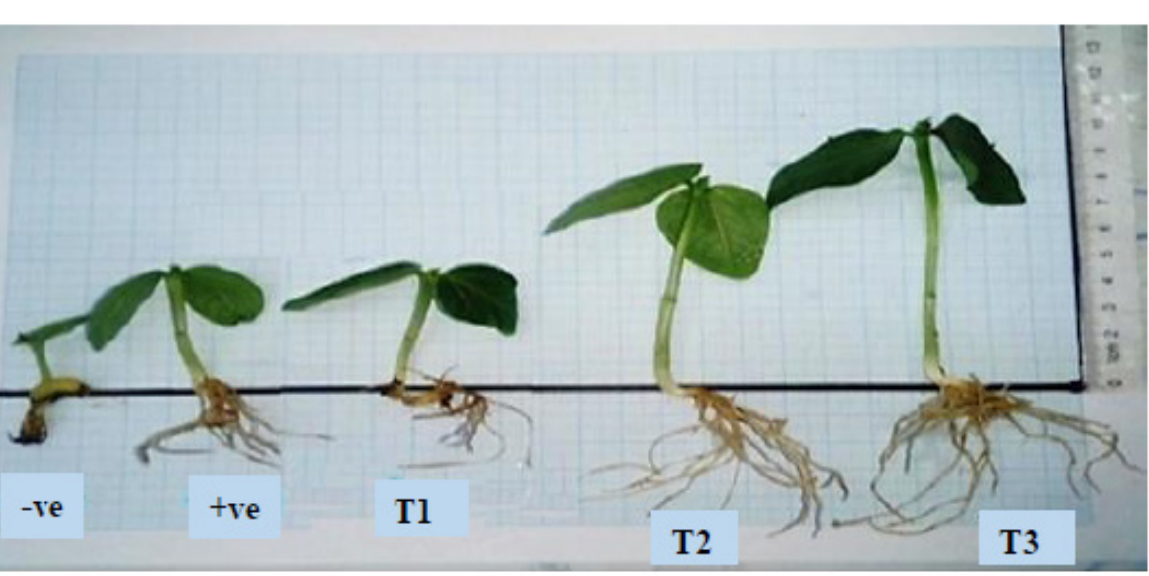
O), Treatment 1= S. paucimobilis TiO NPs biosorbent, 2 2 NPs 2